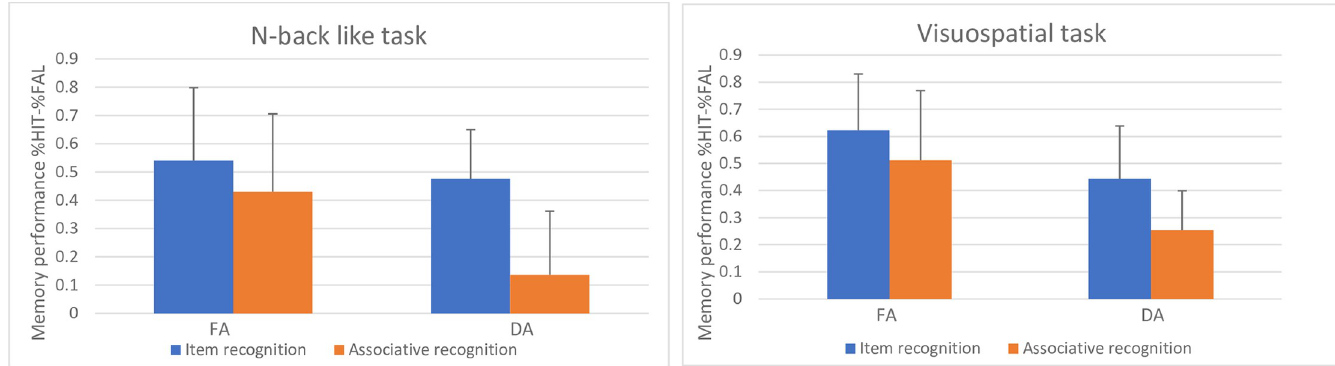
Fig 3. Memory performance in Experiment 2; proportion of hits minus false alarms (FAL) in full- (FA) and divided-attention (DA) conditions for the two experimental groups. The error bars represent standard error of the mean.